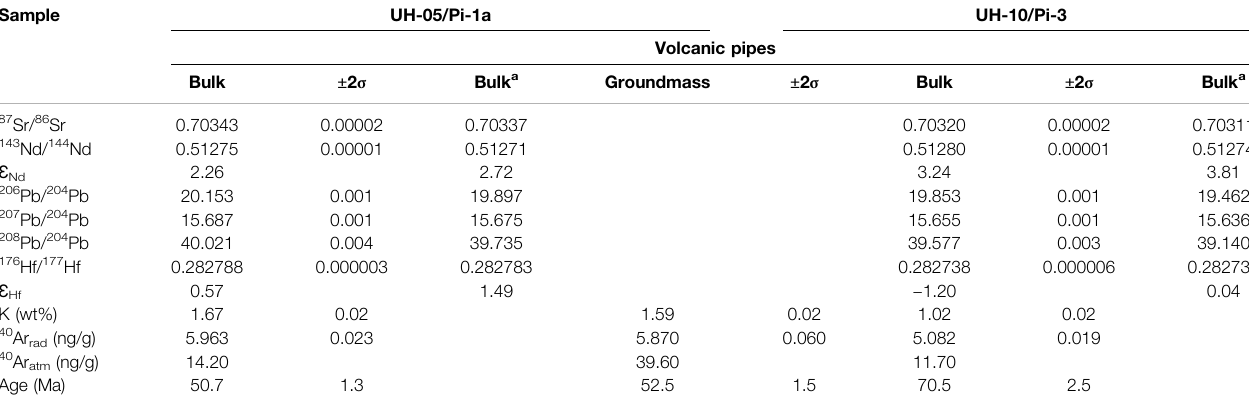
TABLE 1 | Bulk rock Sr, Nd, Pb and Hf isotopic contents and K-Ar dates of selected Marthoum pipes.